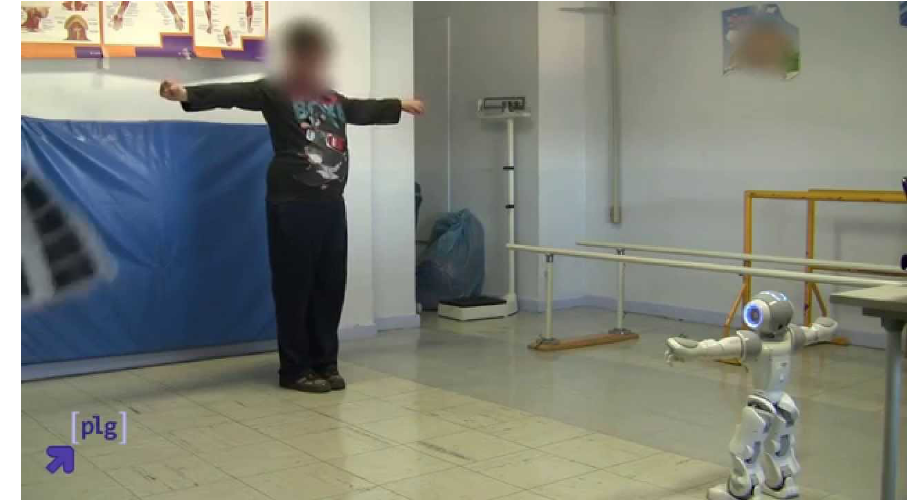
Figure 1. A patient with the NAO robot in a NAOTherapist